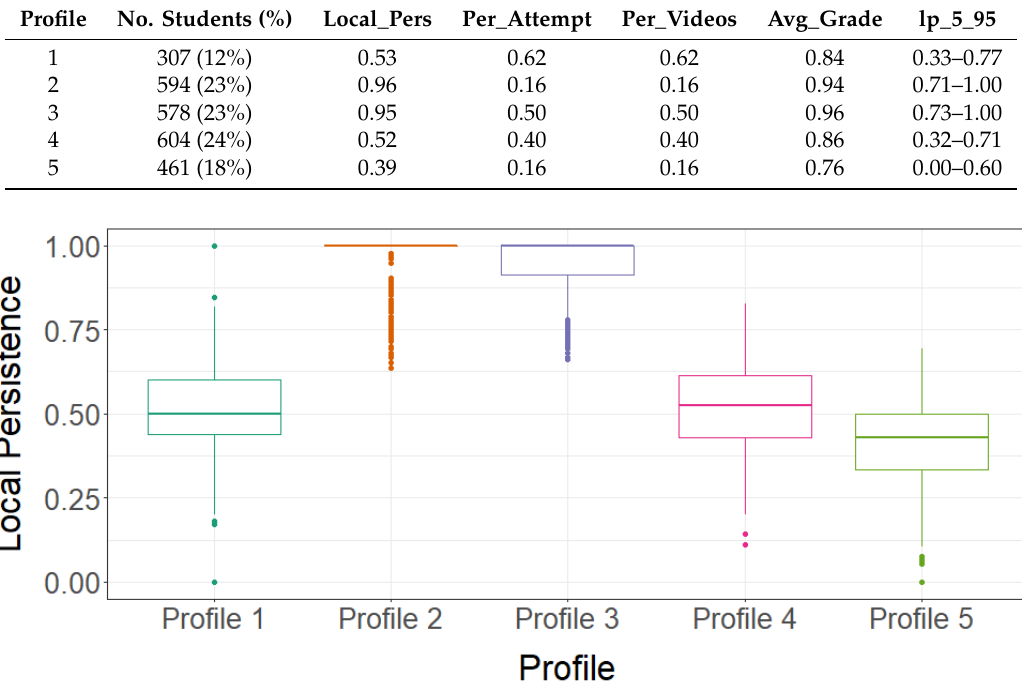
Figure 2. Boxplot of local persistence for each profile.